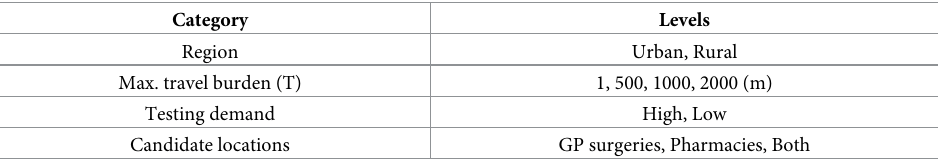
Table 1. Summary of the factors evaluated in the different experiments of the